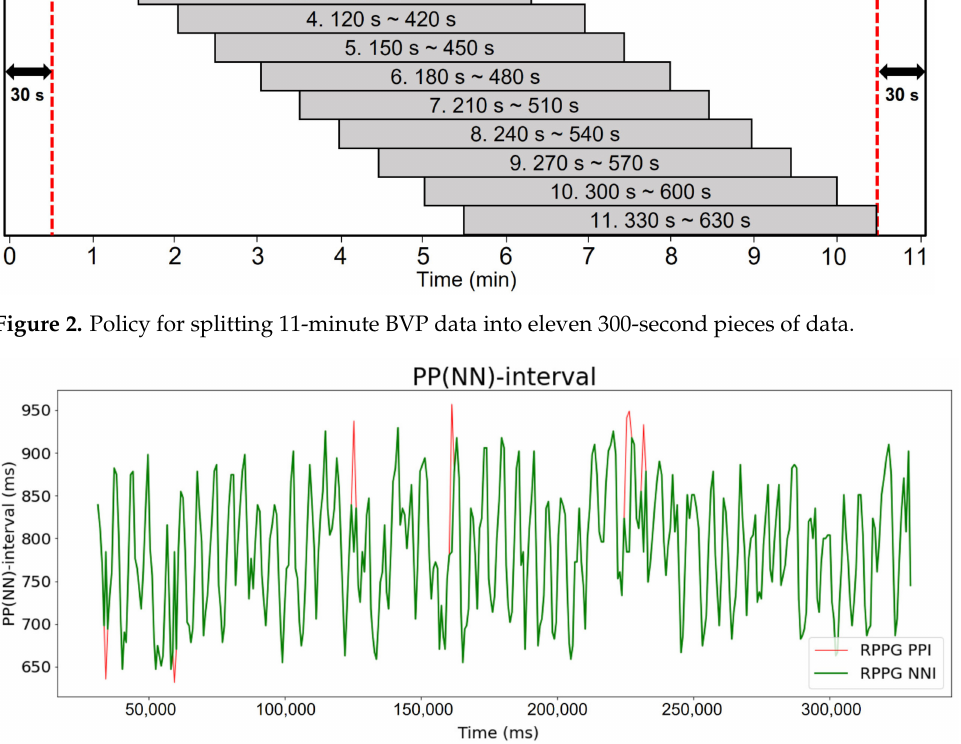
Figure 3. Examples of peak-to-peak interval (PPI) and normal-to-normal interval (NNI) extracted from